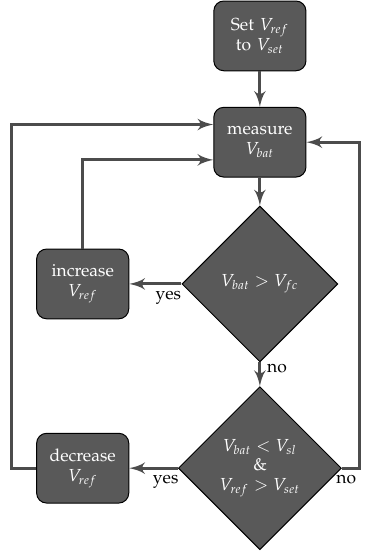
Figure 9. Excess energy management